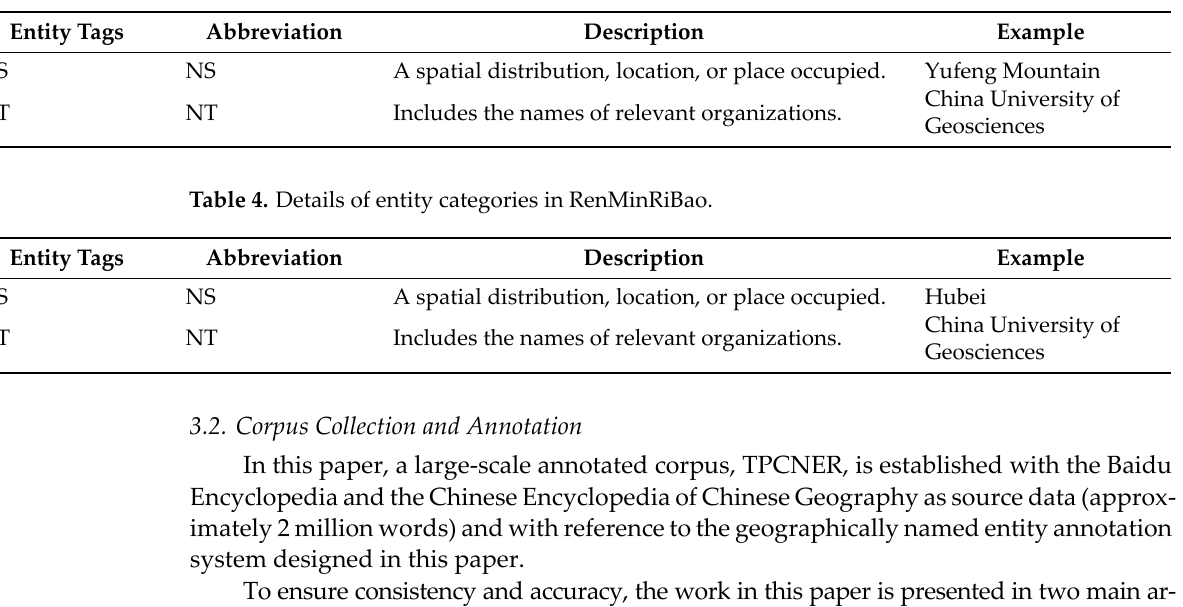
Table 3. Details of entity categories in MSRA.